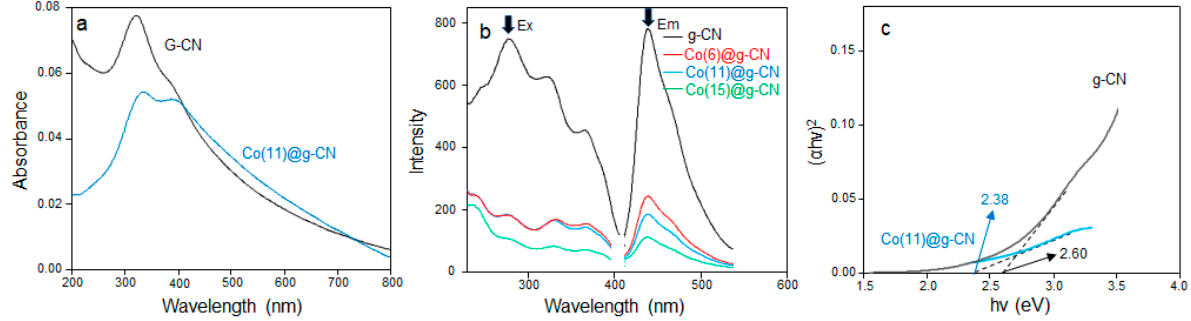
Figure 5. ( a ) UV-visible absorption spectra of g-CN and Co(11)@g-CN, ( b ) fluorescence spectra of g- CN and Co(x)@g-CN (x = 6, 11, 15), and ( c ) Tauc plots of g-CN and